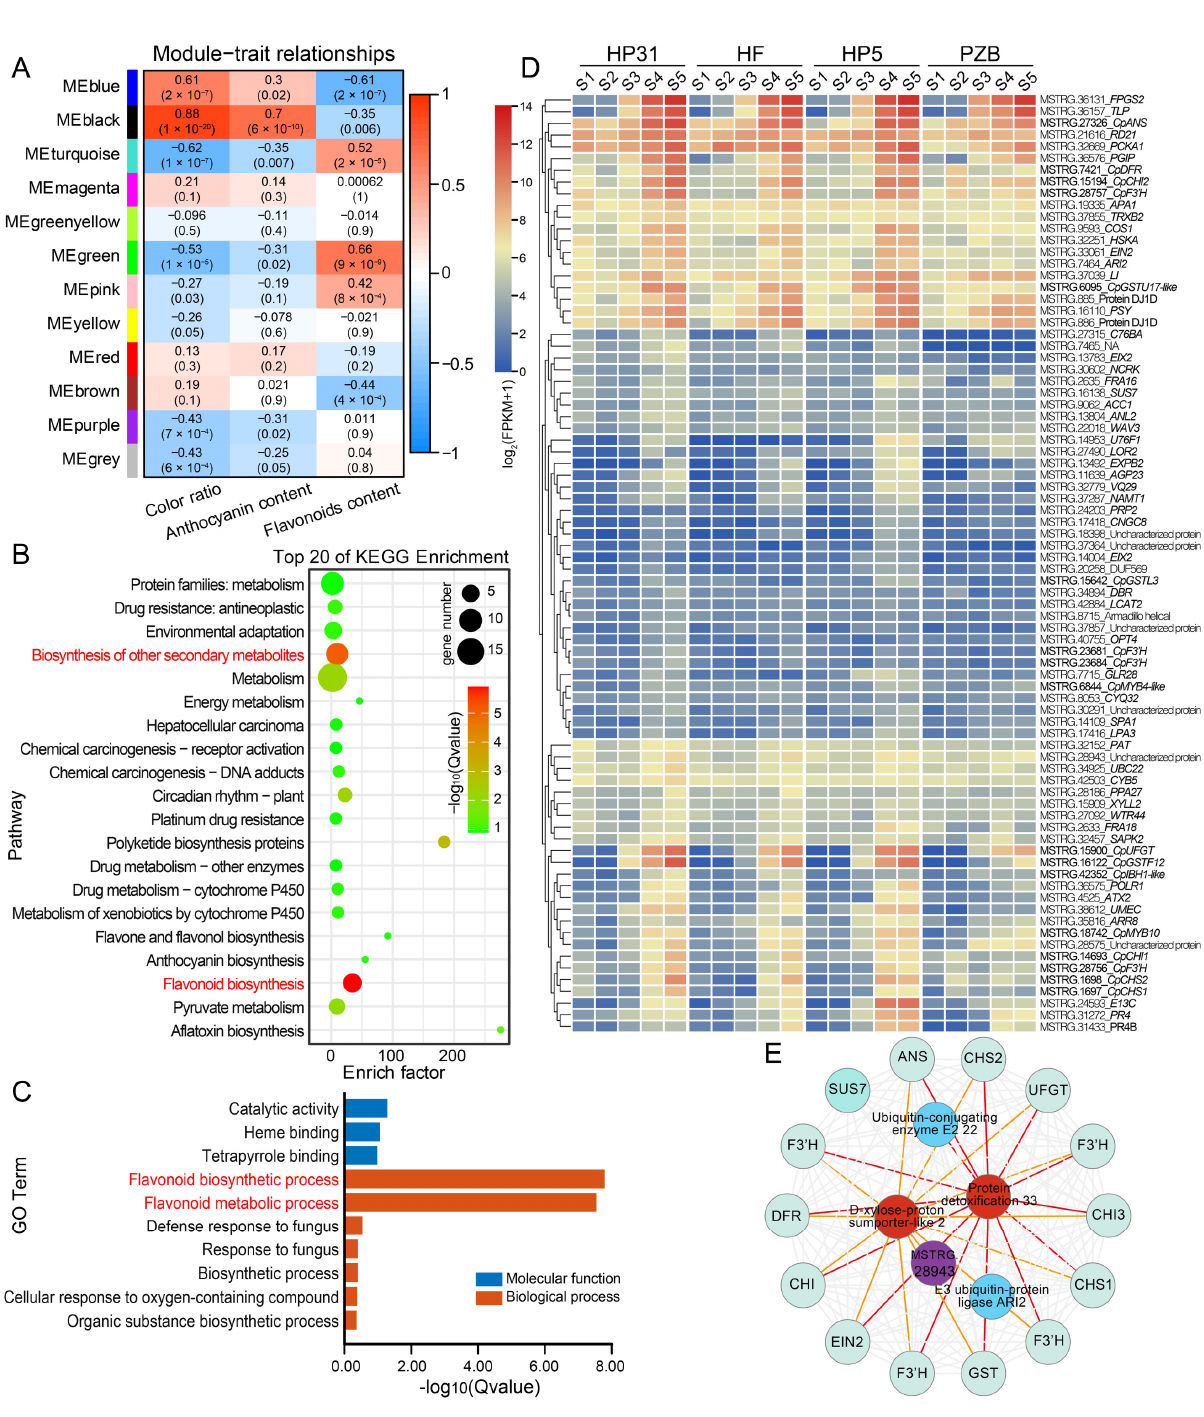
Figure 2. WGCNA recognized gene networks and key candidate genes associated with anthocyanin biosynthesis during fruit development of Chinese cherry. ( A ) Module–trait relationships based on Pearson correlations. The color key from blue to red represents r 2 values from − 1 to 1. ( B ) KEGG enrichment analysis of with the top 20 KEGG pathways in the genes in the MEblack module. ( C ) GO enrichment analysis of genes in the MEblack module. ( D ) Heatmap of the expression level of genes in the MEblack module. The color scale of the heatmap represents expression levels as log 2 (FPKM + 1). ( E ) Genes whose expression was highly correlated in the MEblack module.